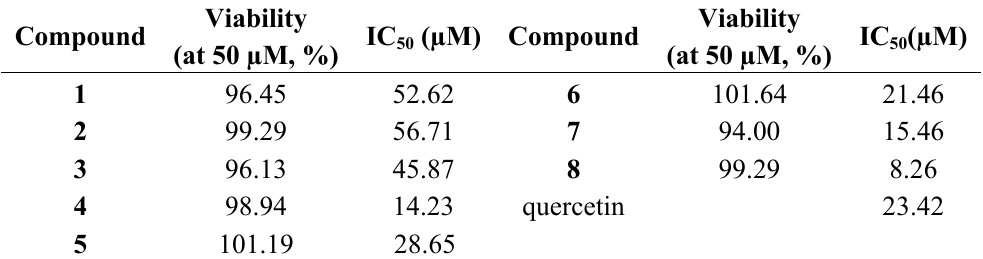
Table 2. Inhibitory effects of compounds 1 – 8 and